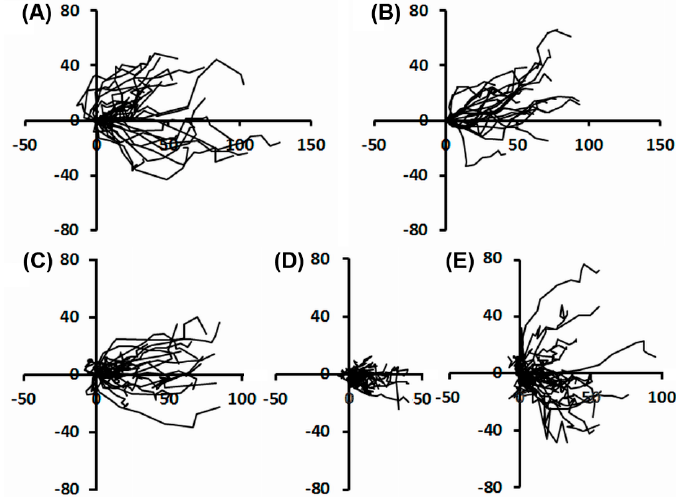
Figure 5. Effects of UVA exposure on the motile ability of keratinocytes, in terms of their directionality of movement. ( A ) Trajectories of mock-irradiated HaCaT cells during the first 5 h after scratching; ( B ) trajectories of HaCaT cells irradiated for 30 min, during the first 5 h after scratching; ( C ) trajectories of mock-irradiated DOK cells during the first 5 h after scratching; ( D ) trajectories of DOK cells irradiated for 30 min, during the first 5 h after scratching; ( E ) trajectories of DOK cells irradiated for 30 min, monitored between 5 and 13 h after scratching. Units in plots are in µ m.